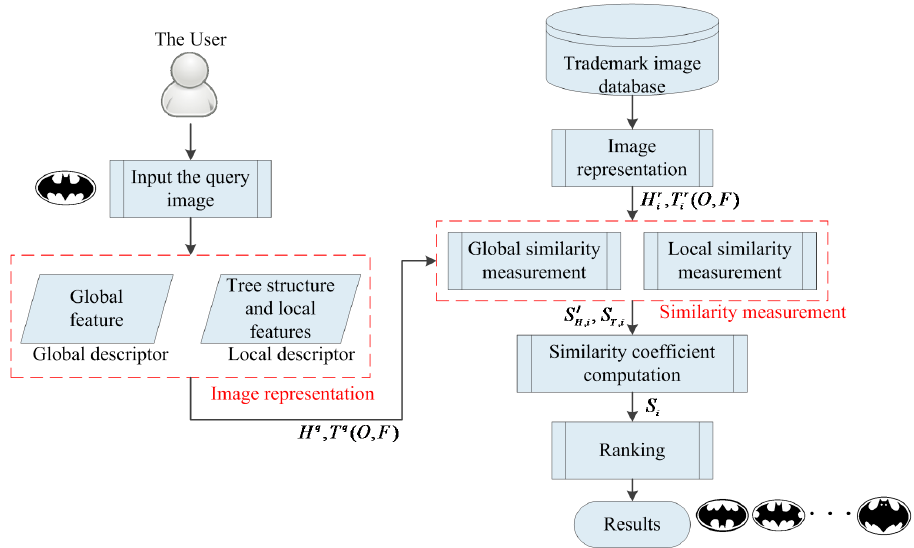
Figure 1. Architecture of the proposed trademark image retrieval technique.